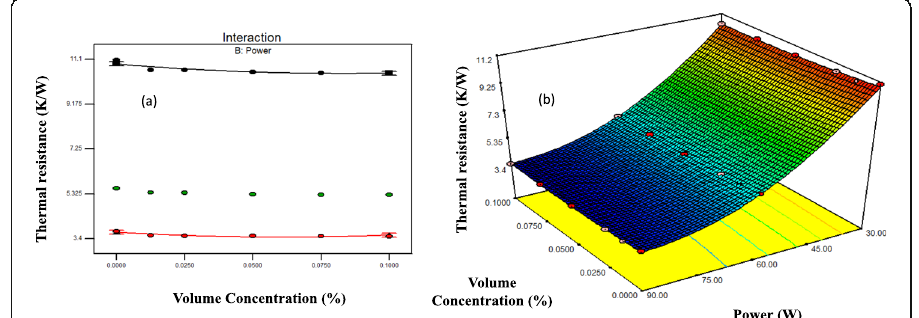
Fig. 10 a Interaction effect of thermal resistance of hybrid nanofluid. b Response surface plot